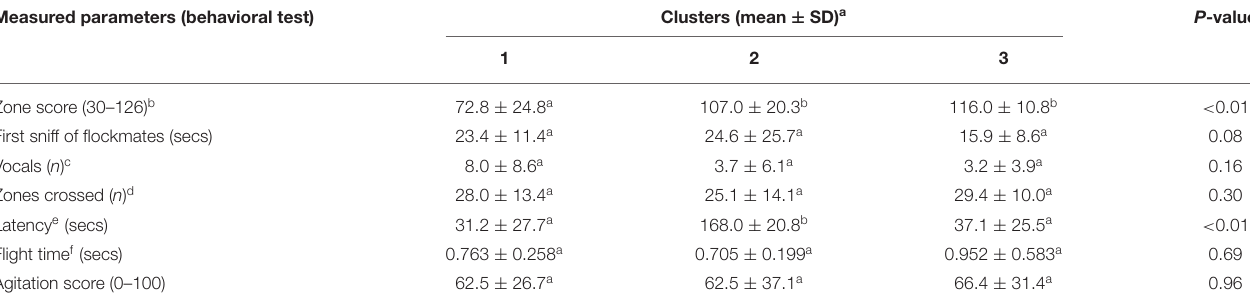
TABLE 1 | Mean ( ± standard deviation) of the measured parameters of sheep behavior in different clusters. Measured parameters (behavioral